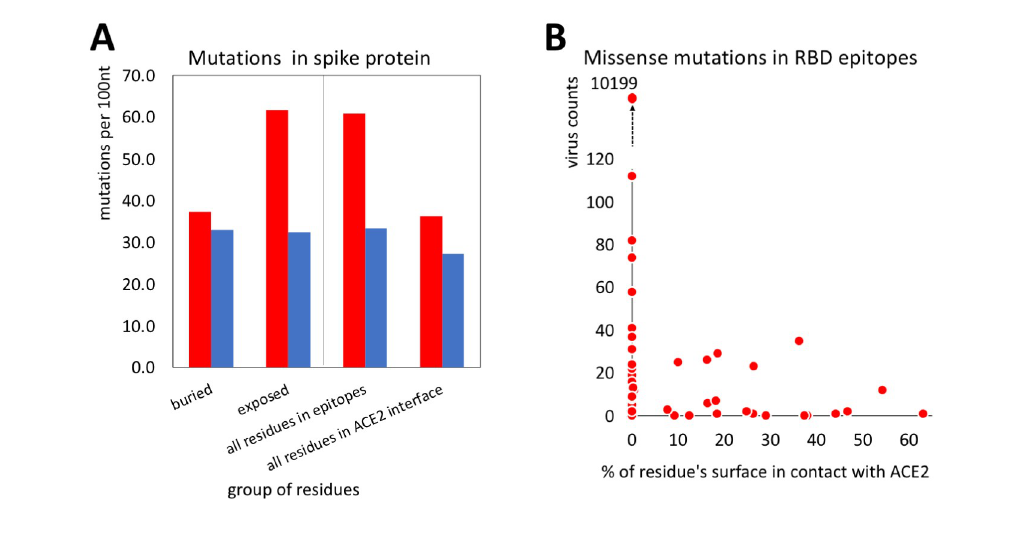
Fig 5. Mutations in known epitopes of the RBD of SARS-CoV-2 spike protein: A) Frequencies of missense (red) and synonymous (blue) mutations in (from the left to right): residues buried in the Spike protein core, in its exposed residues, in all residues from (structurally characterized) epitopes in RBD, and in all residues involved in binding to the human ACE2 receptor. B) The virus counts of missense mutations in epitopes as a function of the percent of residue’s surface that is involved in the RBD-ACE interface.